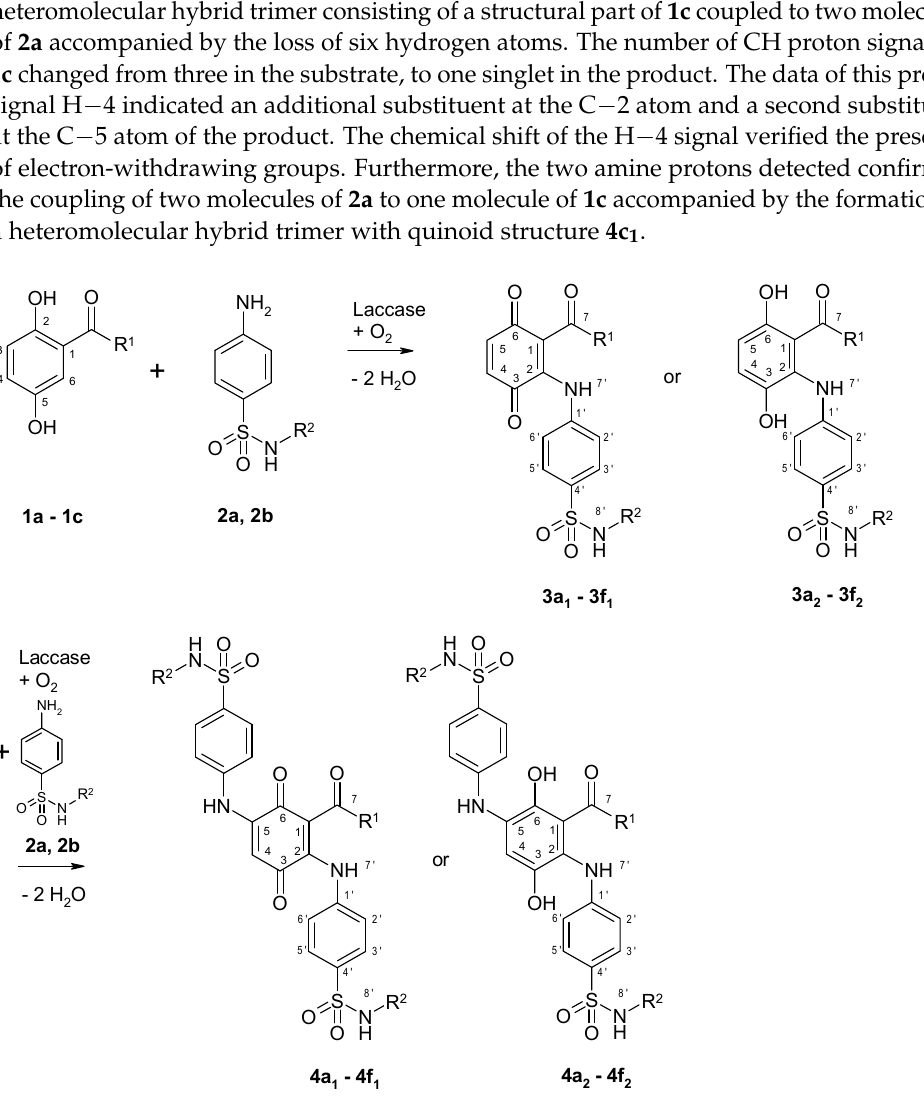
Figure 1. Laccase-mediated reactions of 2,5-dihydroxybenzene derivatives ( 1a – 1c ) with sulfonamides ( 2a , 2b ) for the synthesis of heterodimers and heterotrimers produced as shown in Table 1. (R 1 = OCH 3, NH(CH 2 ) 2 OH, CH 3 ; R 2 = H, CNC(CH 3 )(CH) 2 N). Table 1. Heterodimers and heterotrimers produced by laccase-mediated reactions of 2,5-dihy-